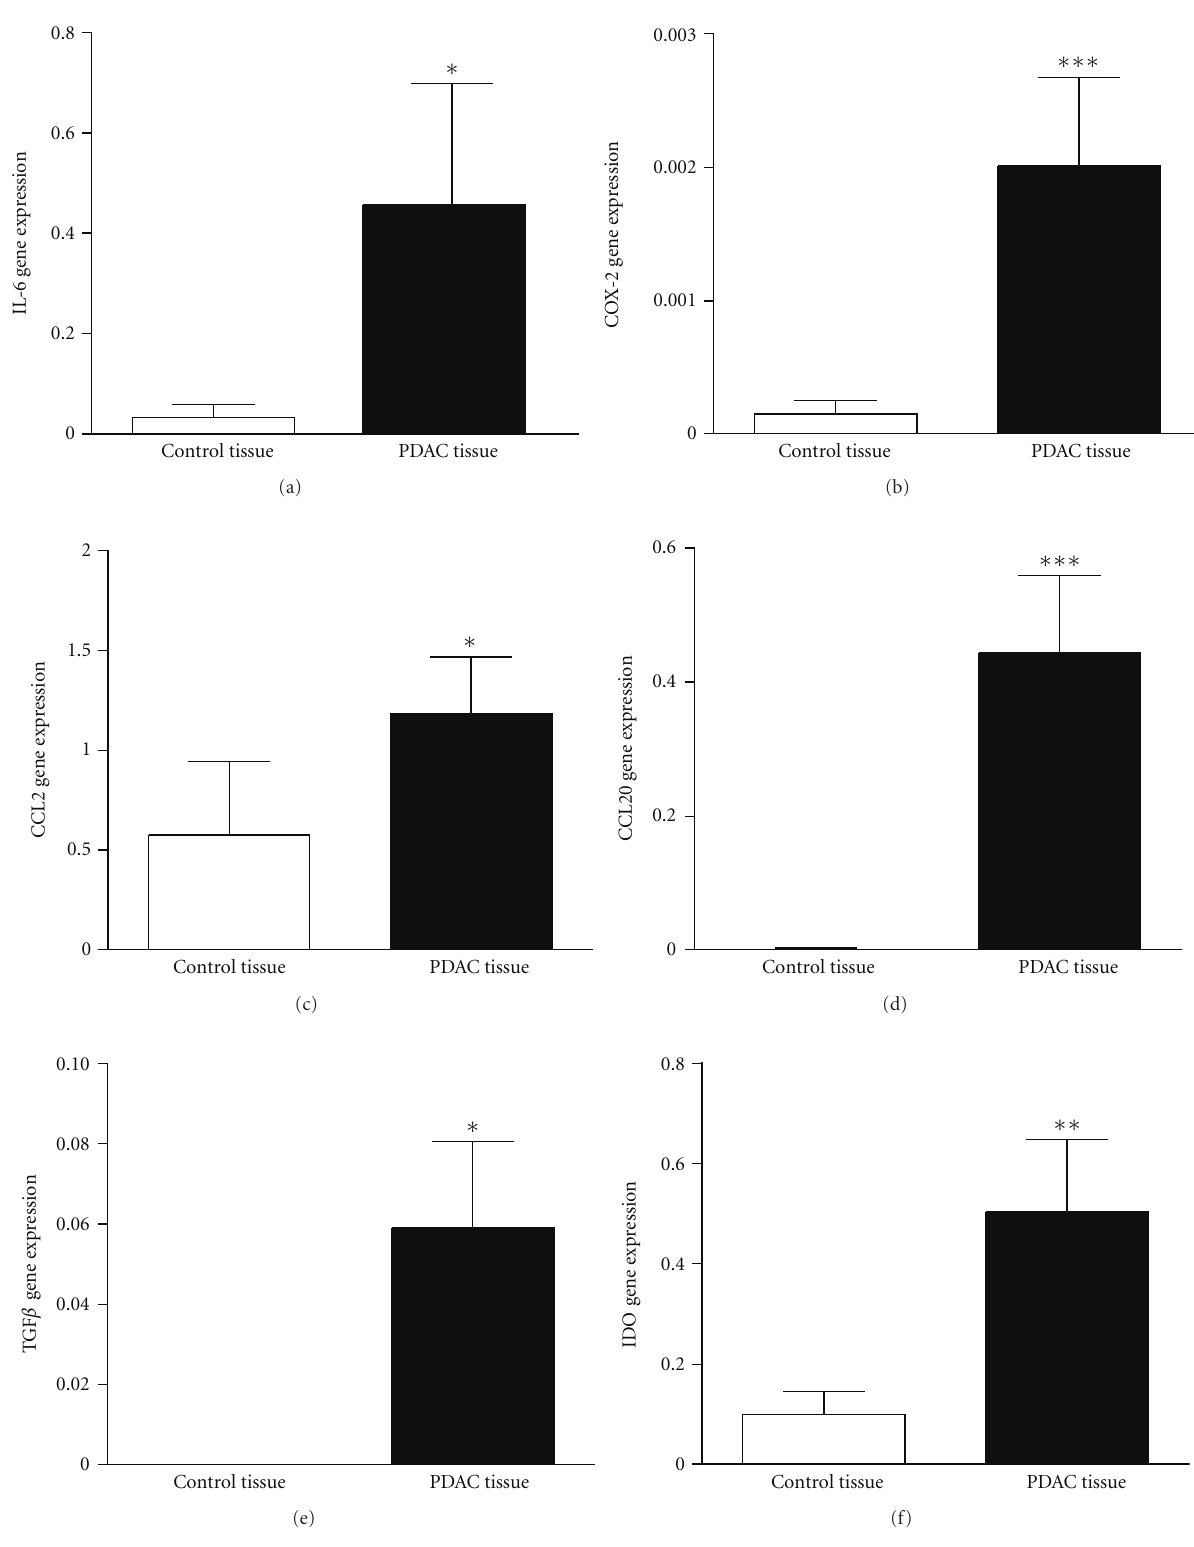
Figure 1: Elevated gene expression levels of inflammatory factors in PDAC tissue. RNA was extracted from PDAC ( n = 30) and normal pancreatic tissue samples ( n = 10) and assessed for relative gene expression levels of the inflammatory factors, IL-6 (a), COX-2 (b), CCL2 (c), CCL20 (d) TGF β (e), and IDO (f). ∗ P < 0 . 05, ∗∗ P < 0 . 05, ∗∗∗ P < 0 .